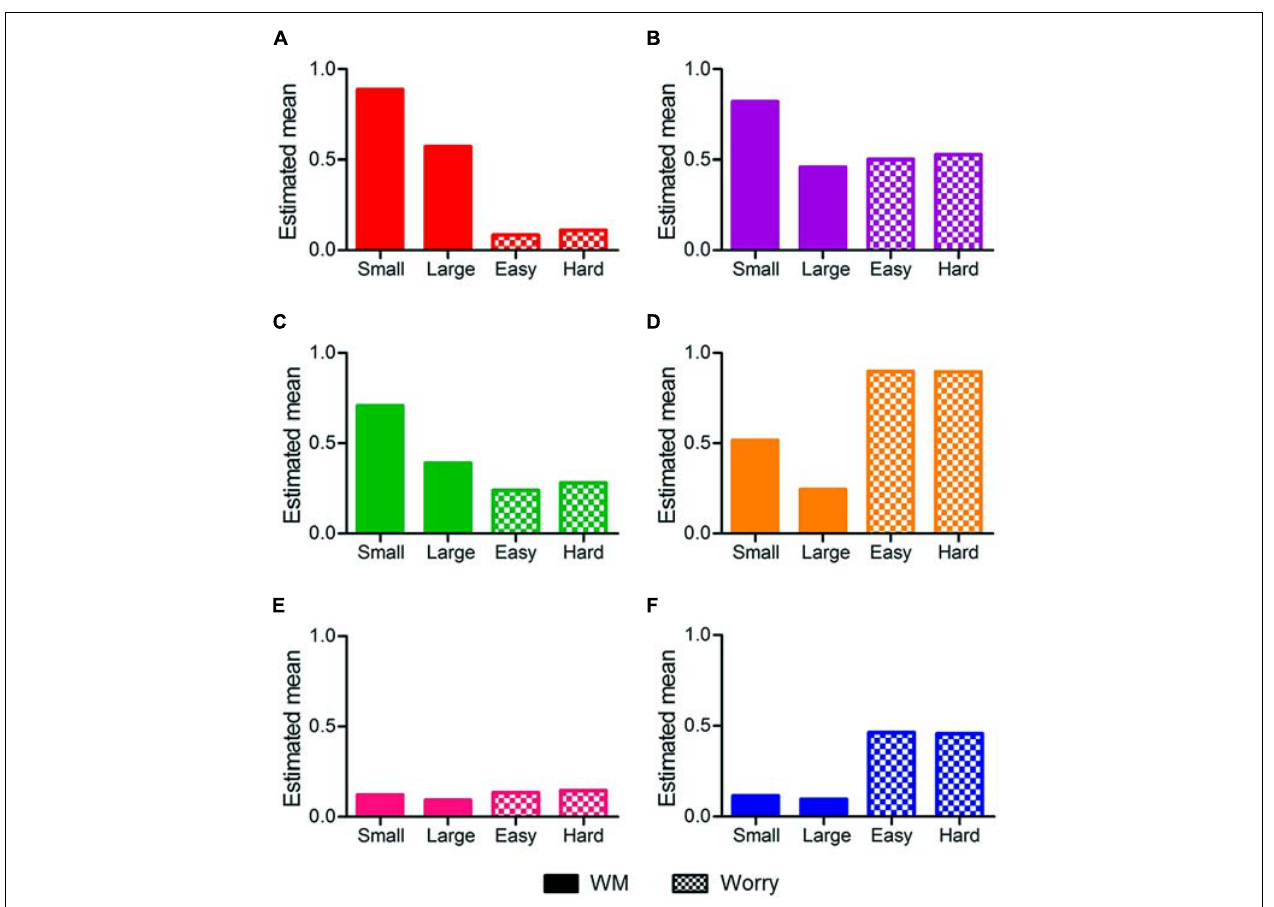
FIGURE 4 | Statuses from the LTA and mean scores onWM small (2 and 3),WM large (4 and 5) sets, andWorry for easy and hard judgments. Statuses are (A) highWM/low worry, (B) highWM/high worry, (C) moderateWM/low worry, (D) moderateWM/high worry, (E) lowWM/low worry, and (F) lowWM/high worry.